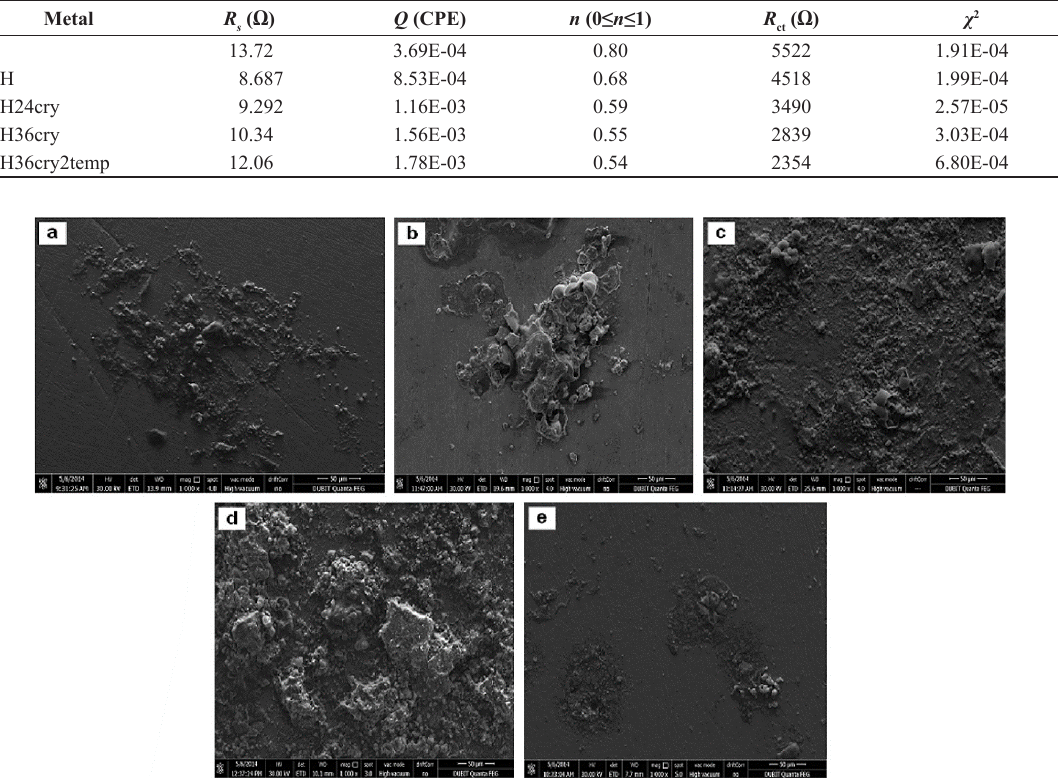
Figure 4. SEM images for different pre-treatment AISI D3 steel samples in 3.5% NaCl solution: (a) Q, (b) QH, (c) QH24cry, (d) QH36cry, (e) QH36cry2temp